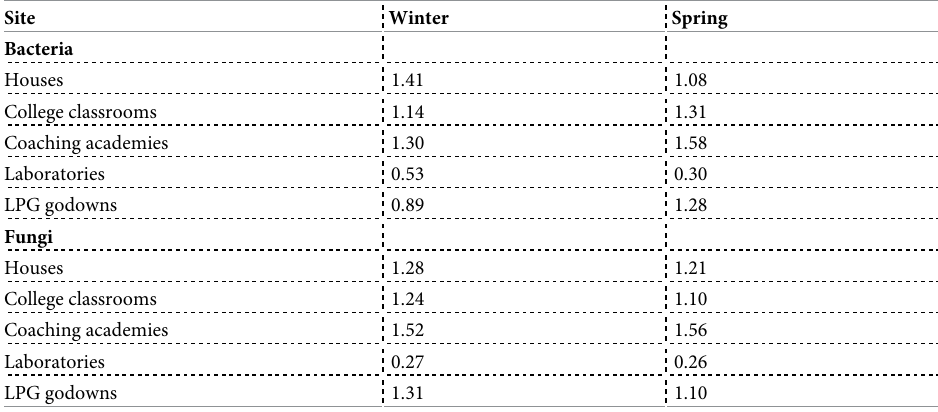
Table 5. Indoor and outdoor microbial ratios (I/O ratio) in different sampling sites in both the seasons.